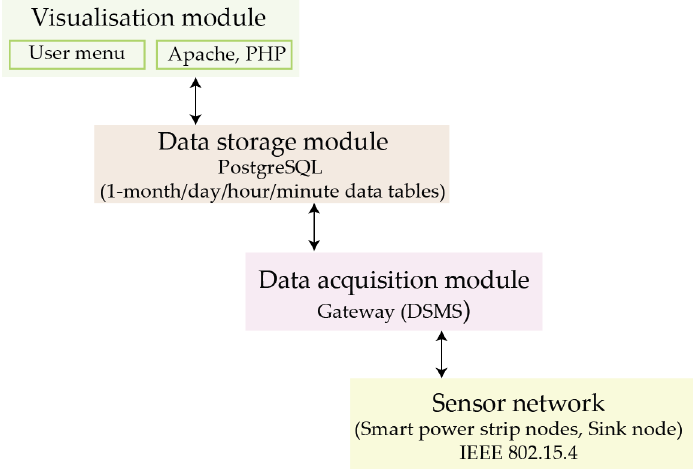
Figure 4. A four-layer arhitecture for energy monitoring (after Ref.